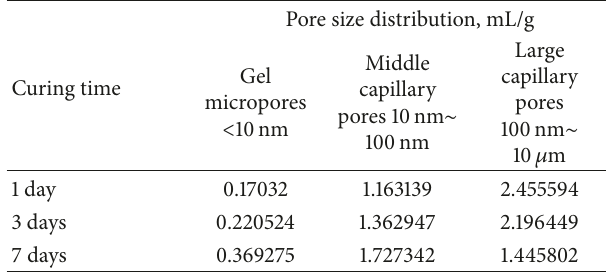
Table 1: Three types of pore diameter volume at natural curing